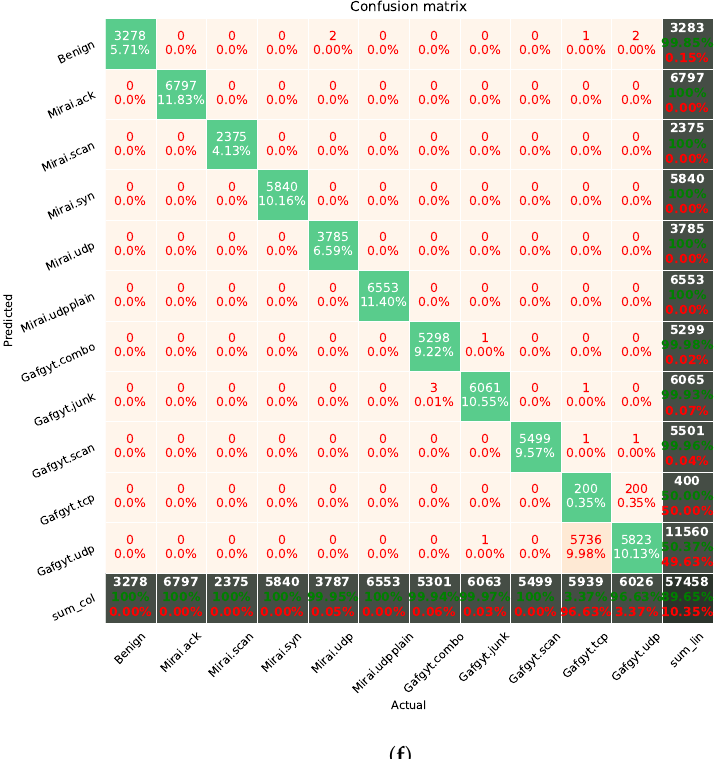
Figure 3. Confusion matrix for ( a ) RF-RF, ( b ) XGB-RF, ( c ) RF-RFECV, ( d ) RF-RFE, ( e ) RF-SelectKBest, ( f ) RF-WFS. Note that X -axis shows the actual label whereas Y -axis represents the predicted label by the classifier.